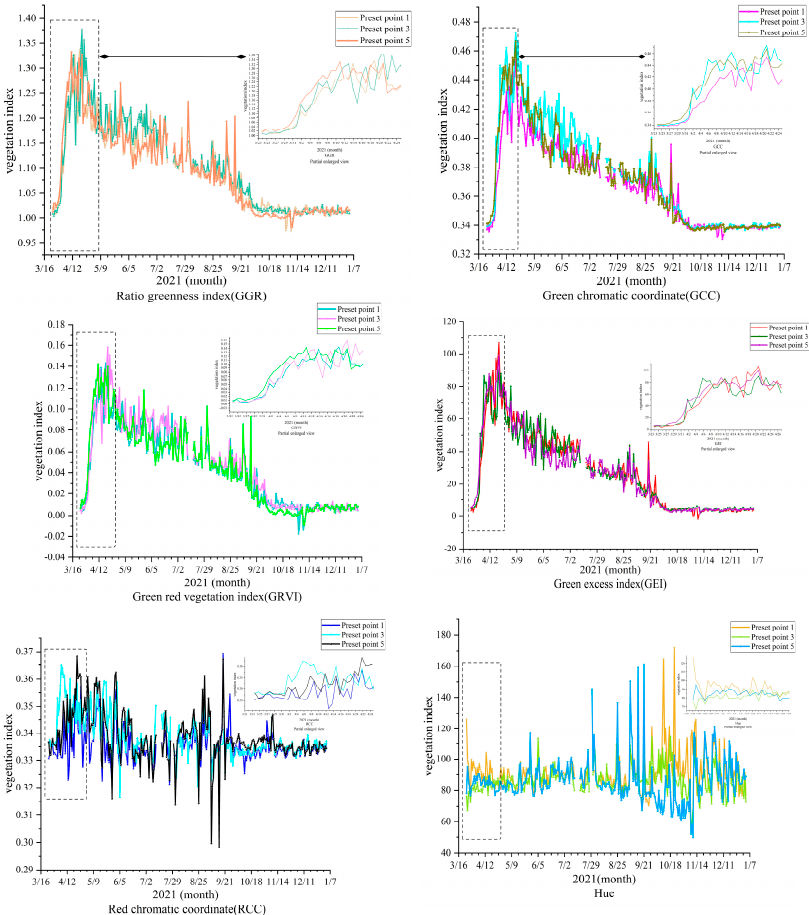
Figure 7. Vegetation index analysis of different irrigation methods.